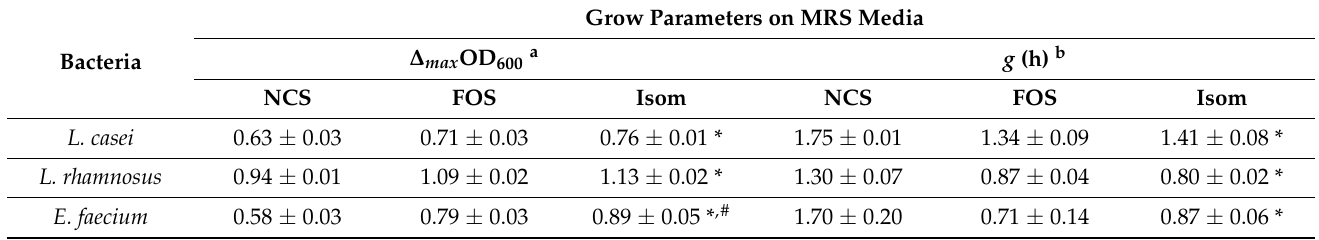
Table 2. Growth parameters of probiotic cultures supplemented with the indicated carbon